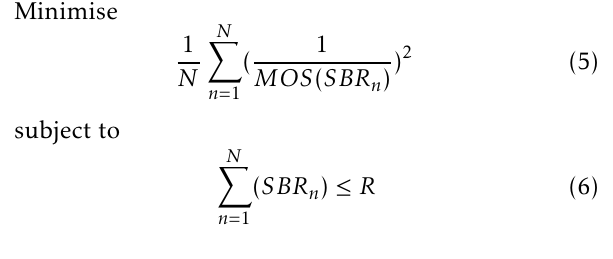
algorithm based adaptation